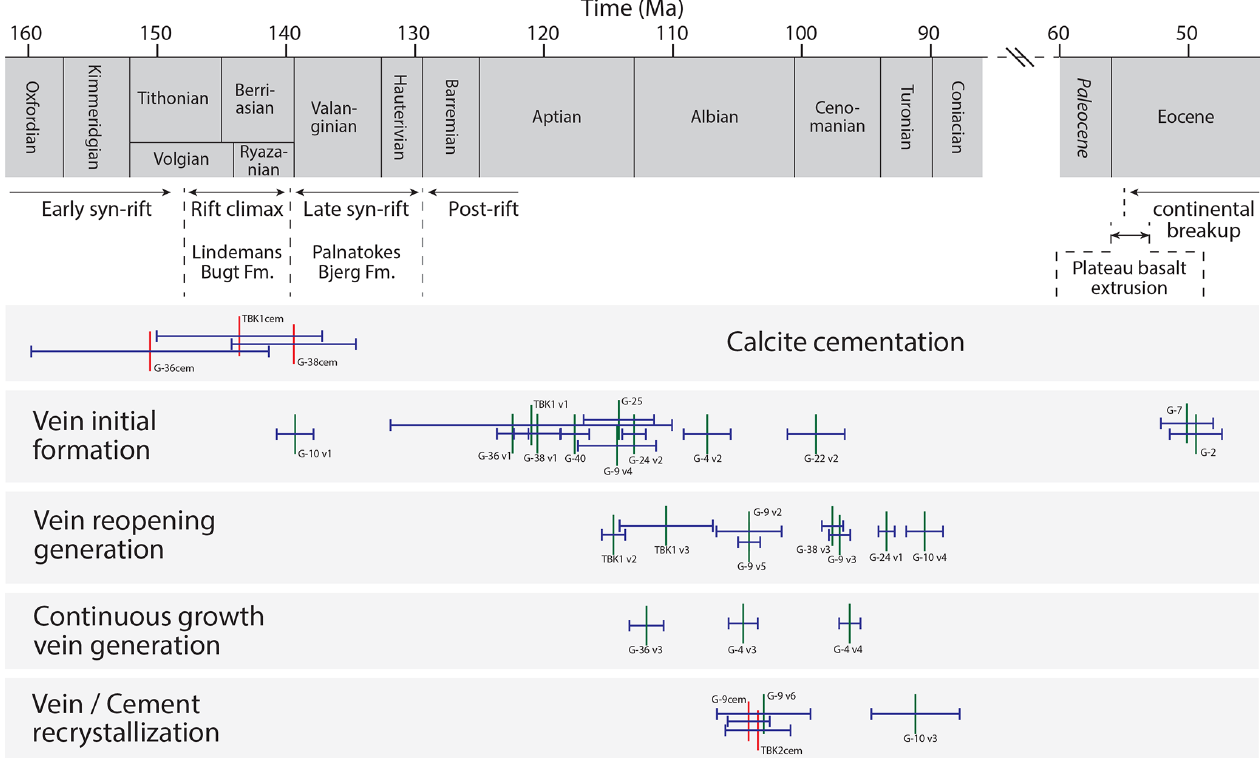
Figure 8. Timeline with formation ages of cements (red vertical bar) and veins (green vertical bar), separated into calcite cementation (cement growing in pore space), vein initial formation (first generation of calcite vein growth), vein reopening generation (calcite precipitation after renewed fracture opening of initial vein), continuous growth vein generation (veins showing continuous growth zonation after initial vein formation), and vein/cement recrystallization (ages reset due to calcite recrystallization). All samples derive from the Lindemans Bugt Formation. Cf. Table 3. Horizontal blue bars represent 2 σ uncertainty. Numerical ages of regional stages (Volgian and Ryazanian) are after Gradstein et al.